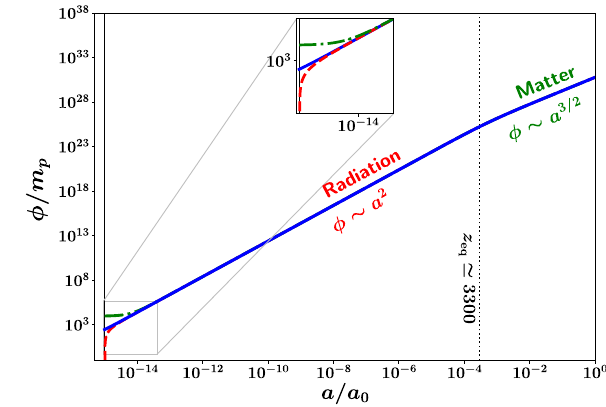
Fig. 7 The evolution of φ is shown for the exponential potential − 2 φ mp . Commencing at z ∼ 10 15 , different initial con- V (φ) = V 0 e ditions (represented by dashed green and red curves) rapidly converge onto the attractor solution (41) (solid blue curve) which corresponds to φ ∝ a 2 during radiation domination and φ ∝ a 3 / 2 during matter domination. The rapid growth in φ is accompanied by a steep decline in V